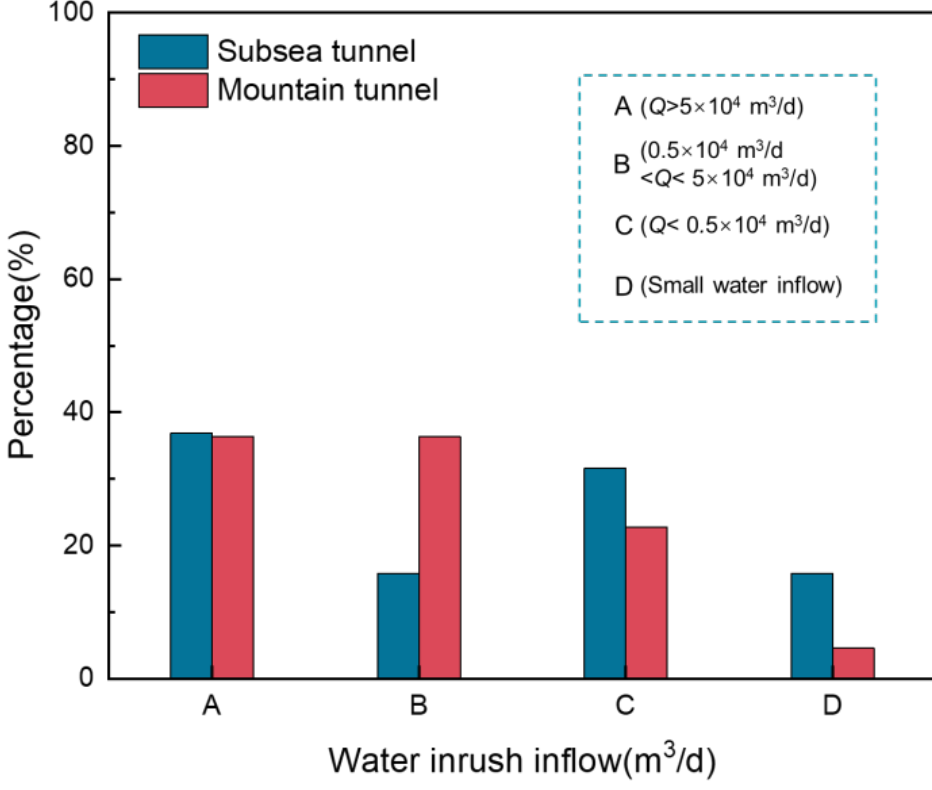
Figure 10. Percentage of water inrush inflow of subsea tunnels and mountain tunnels.